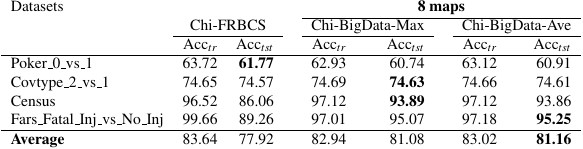
Table 3. Average Accuracy results for the Chi-FRBCS versions Datasets